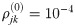
Figure showing how various theoretical quantities of the network defined by Eq (22) depend on the parameters (a, b).Top left: critical γ value. Top right: Expected size of cascades (from Sec. 2.2) when γ = 0.05 and ρjk(0)=10-4. Bottom left: the graph assortativity parameter r. Bottom right: frequency of cascades (from Sec. 2.3) when γ = 0.05.